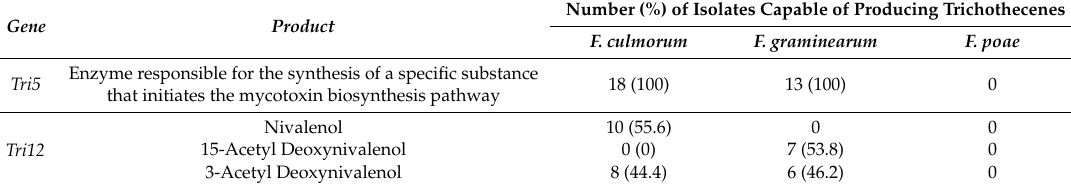
Table 4. Mycotoxin-production ability of Fusarium